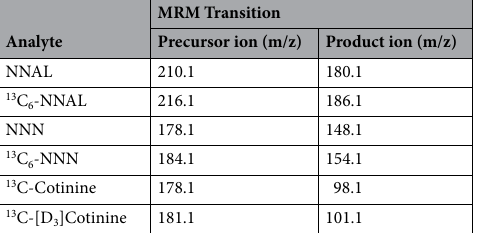
Table 3. MRM transitions of NNAL, NNN and cotinine and their corresponding isotope-labeled internal standards.